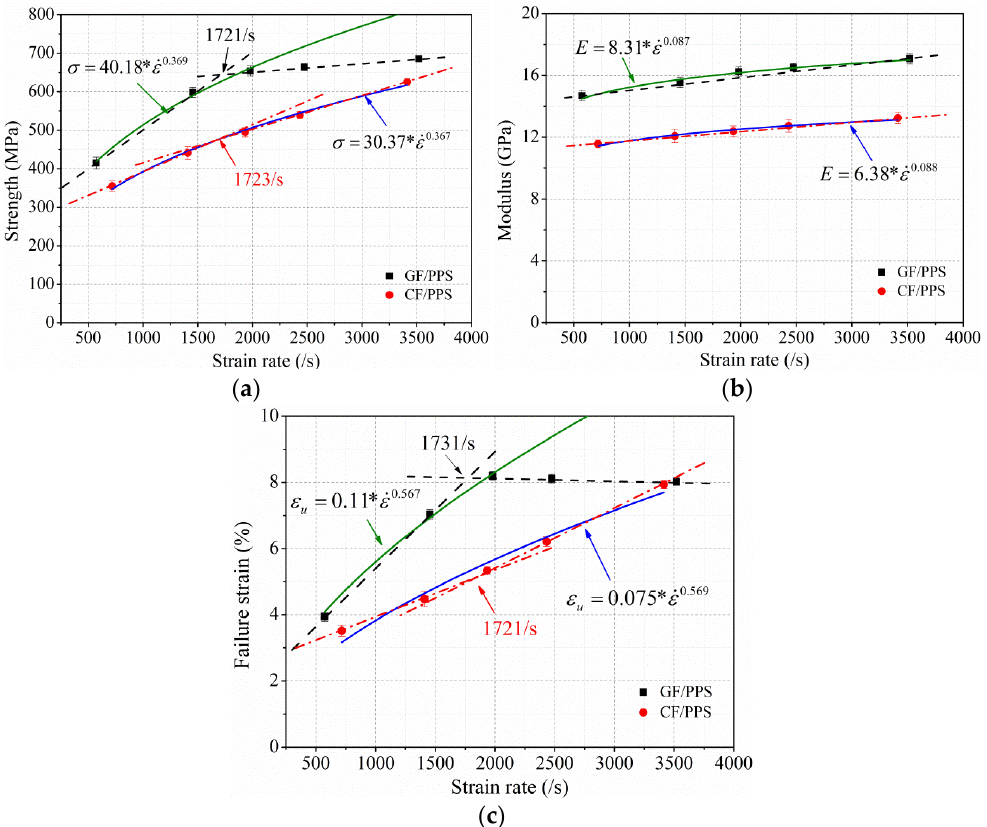
Figure 5. Dynamic properties of thermoplastic composites in out-of-plane direction at various rates. ( a ) Strength; ( b ) modulus; ( c ) failure strain.